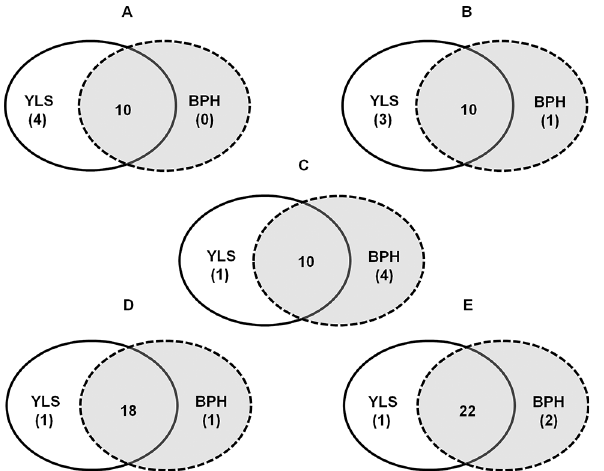
denote the number of enzymes originated from both BPH and